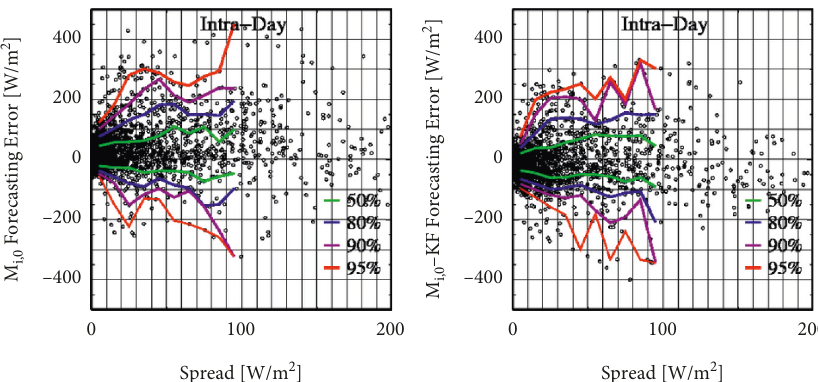
Figure 8: Relationship chart between the ensemble spread and solar GHI’s forecasting error for the intraday prediction by using model , based on WRF and method Kalman filter M i, WRF only M i, 0